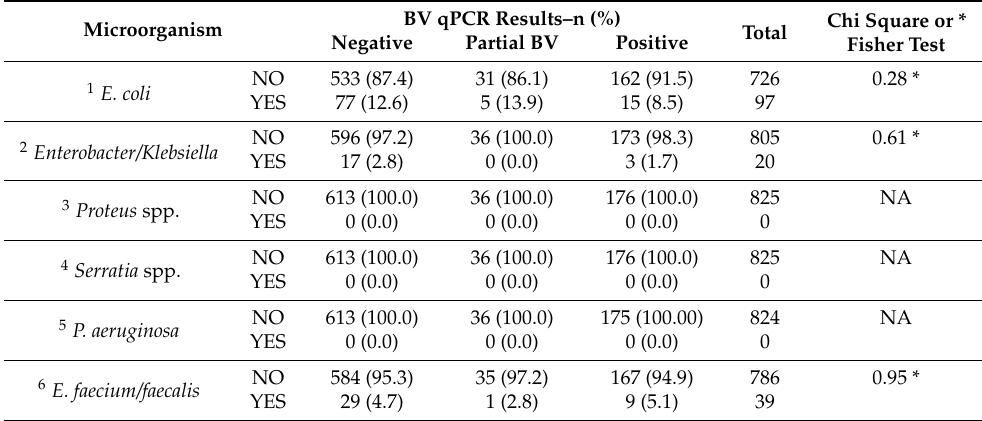
Table 5. Association between a specific species responsible for vaginitis and the presence of bacterial